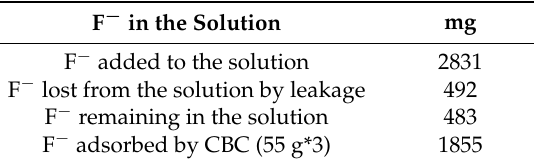
Figure 4. Change in the fluoride concentration of the stock solution. Table 1. Amount of F − in the solution.